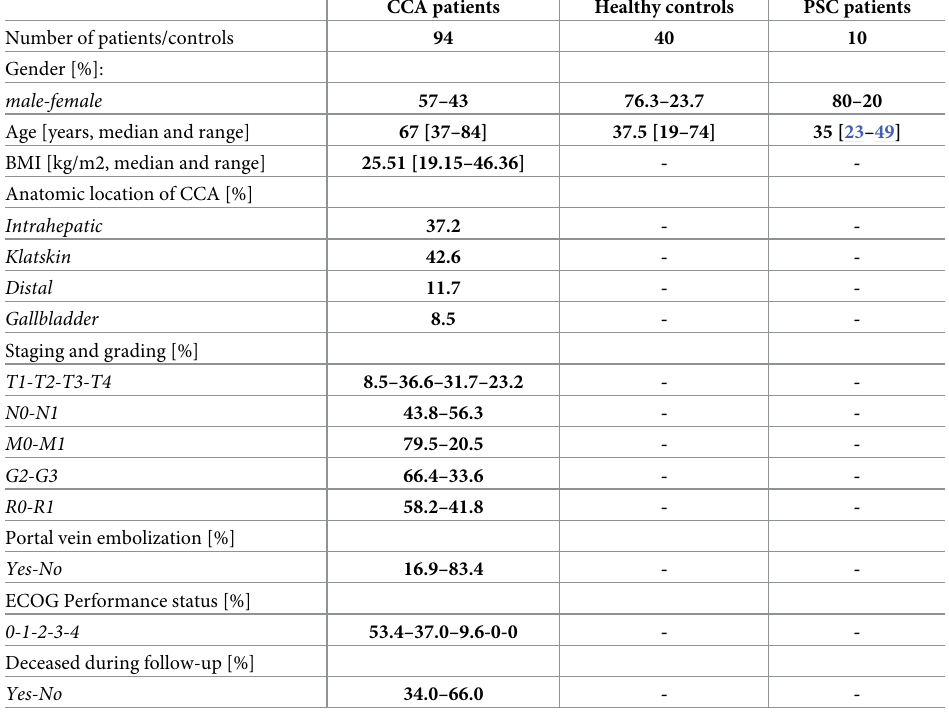
Table 1. Characteristics of study